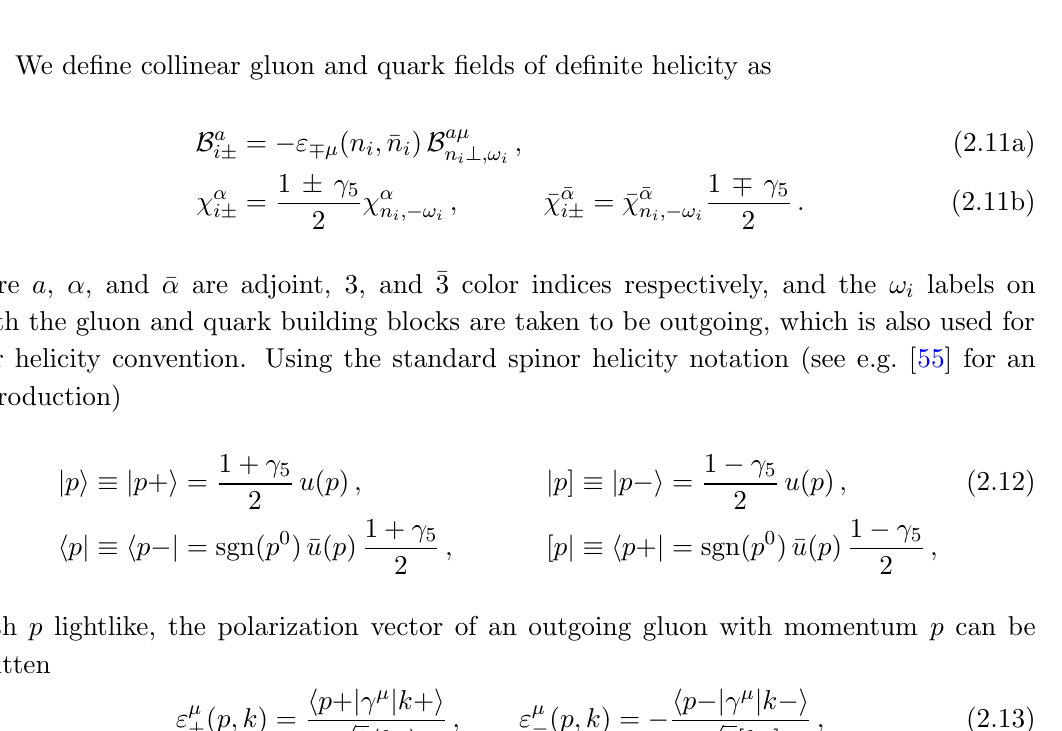
Table 2 . The helicity building blocks in SCET I that will be used to construct a basis of hard scattering operators for gg ! H , together with their power counting order in the (cid:21) -expansion, and the equation numbers where their de(cid:12)nitions may be found. The building blocks also include the conjugate currents J y in cases where they are distinct from the ones